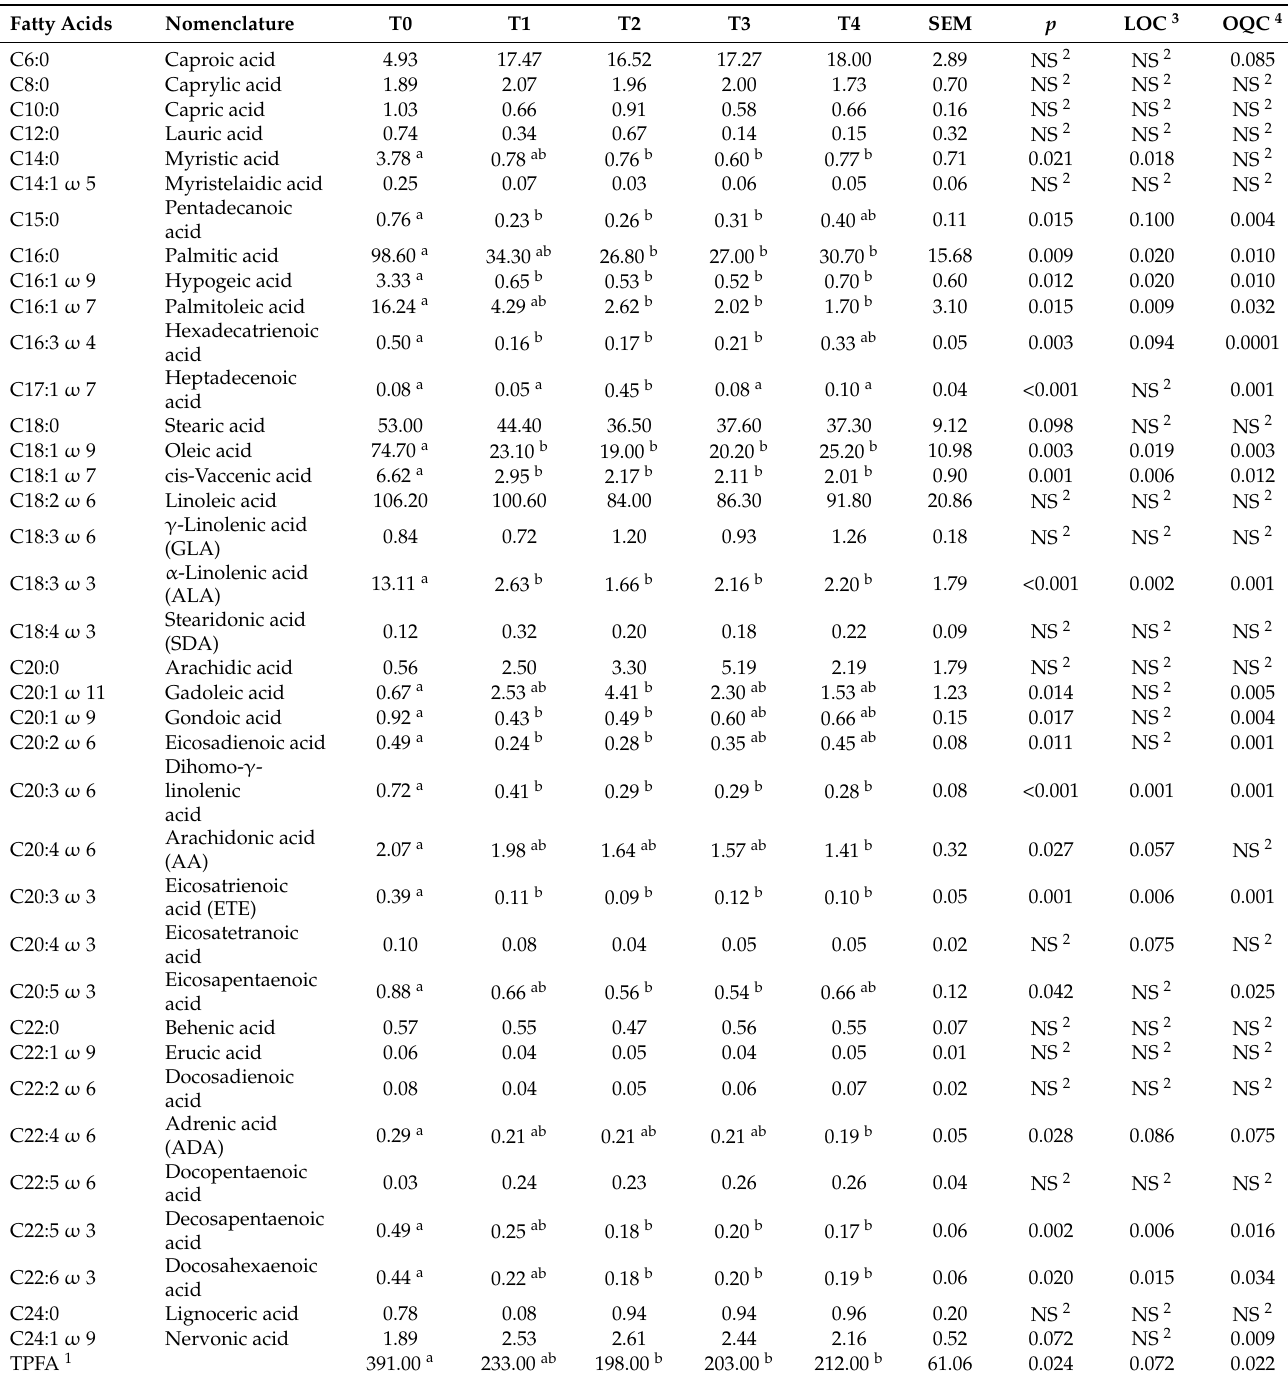
Table 2. Least square means and standard error of the mean (SEM) of identified plasma fatty acids (mg/dL) from pre-foaling (T0: 15 days before foaling) to post-foaling (T1: 15, T2: 30, T3: 60, T4: 90 days after foaling) of